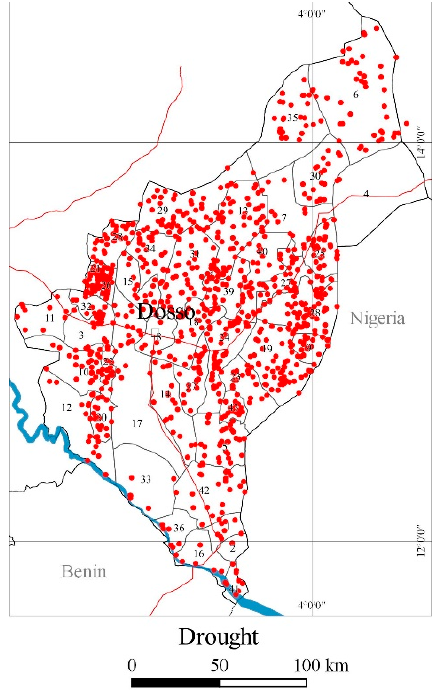
Figure 9. Settlements of the Dosso region affected more than one year (dots) by drought from 2011 to 2017. Table 2. Human settlements in the Dosso region flooded and affected by agricultural drought from 2011 to 2017.